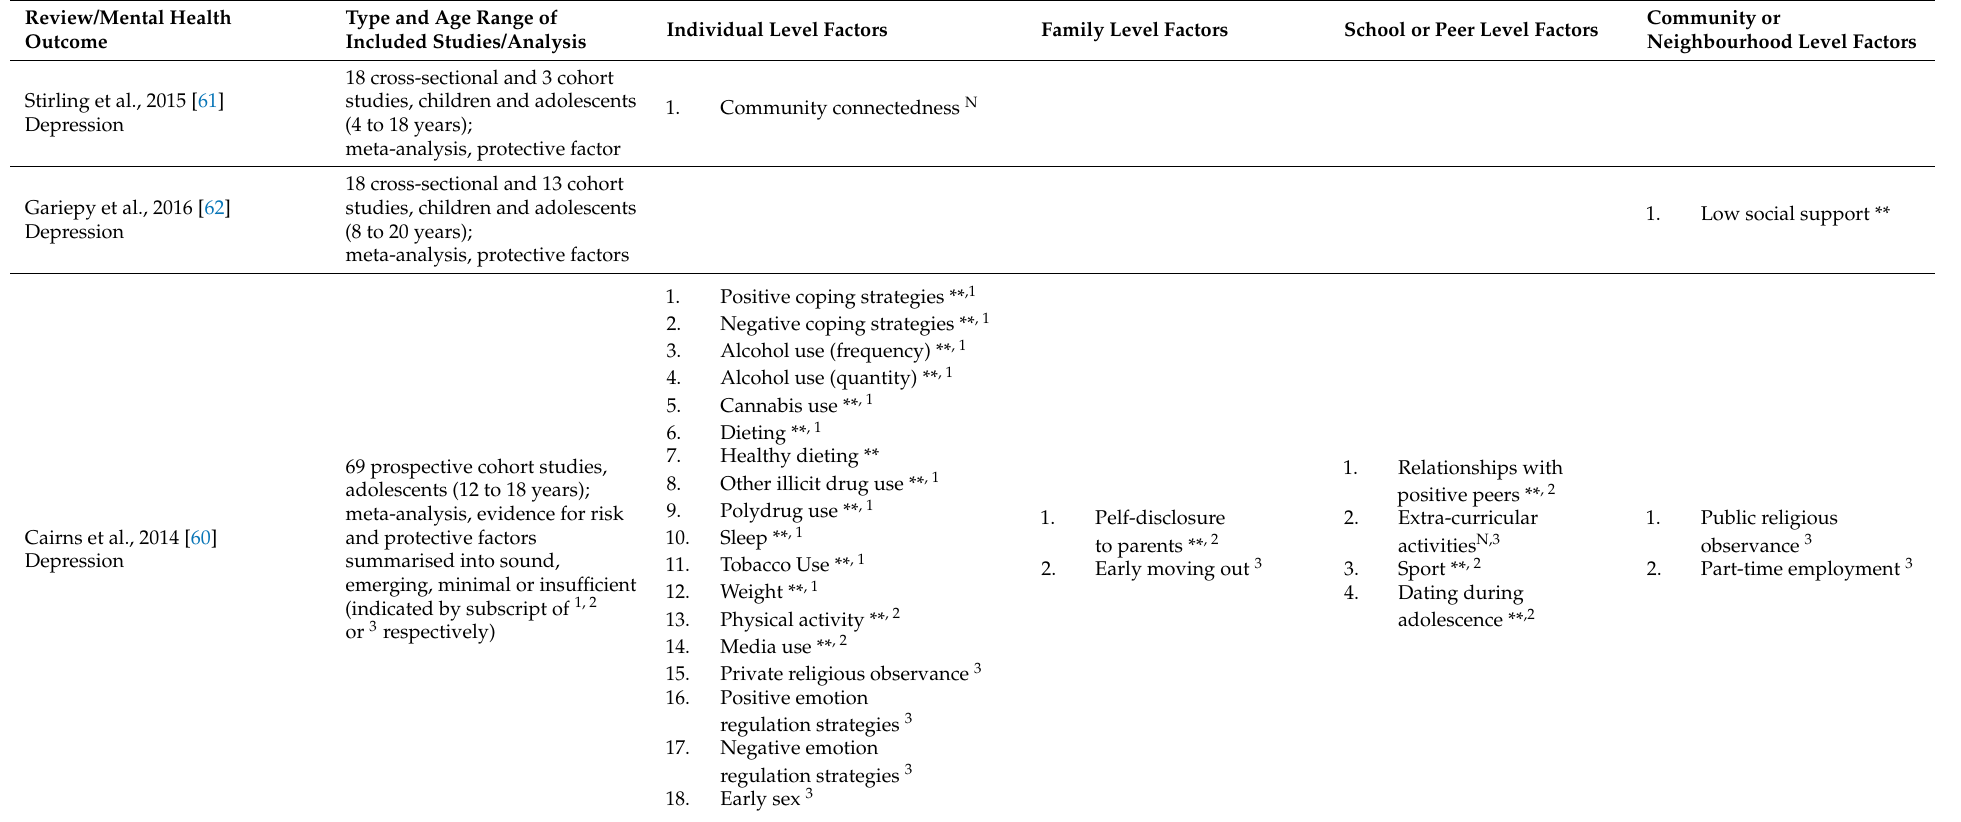
Table 2. Systematic reviews examining associations between mental health problems and protective